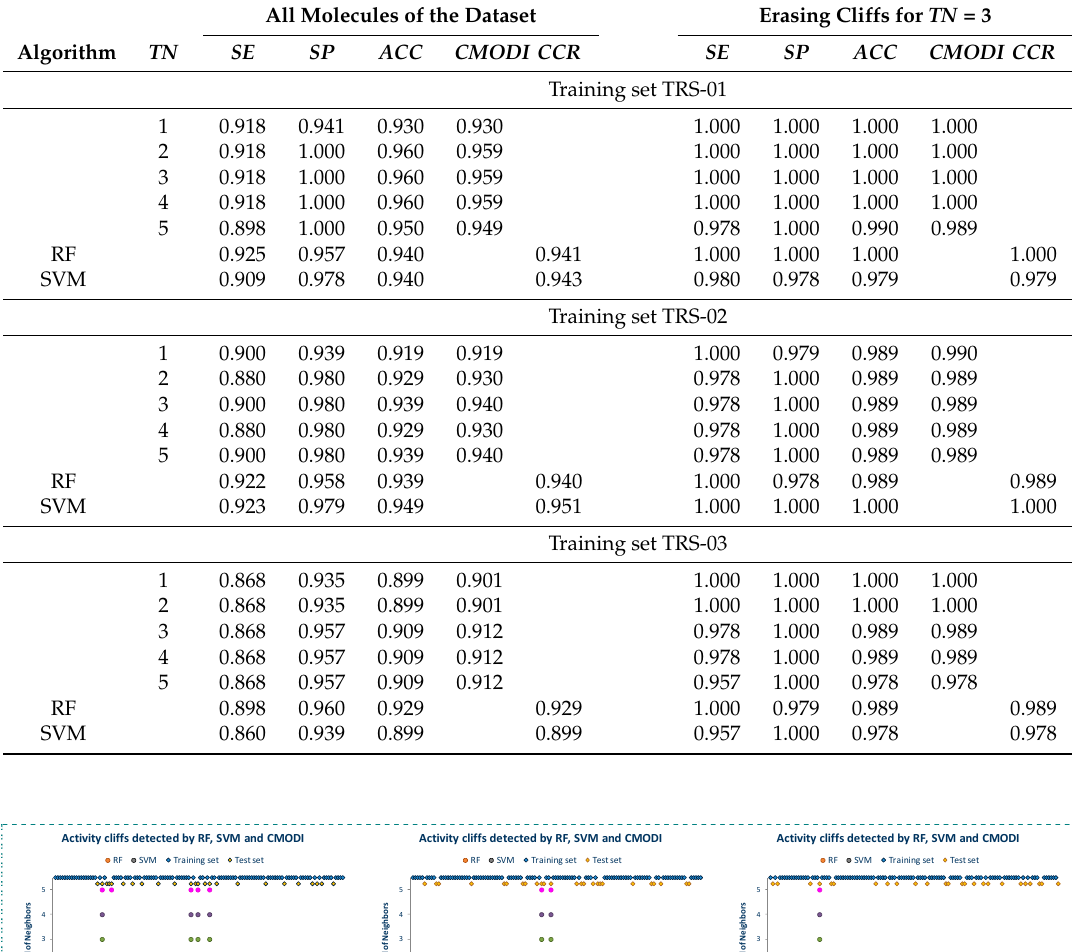
Table 2. Results of the predictions using CMODI for different values of TN and the algorithms for the three whole training sets and the training sets erasing the activity cliffs detected for TN = 3. All Molecules of the Dataset Erasing Cliffs for TN = 3